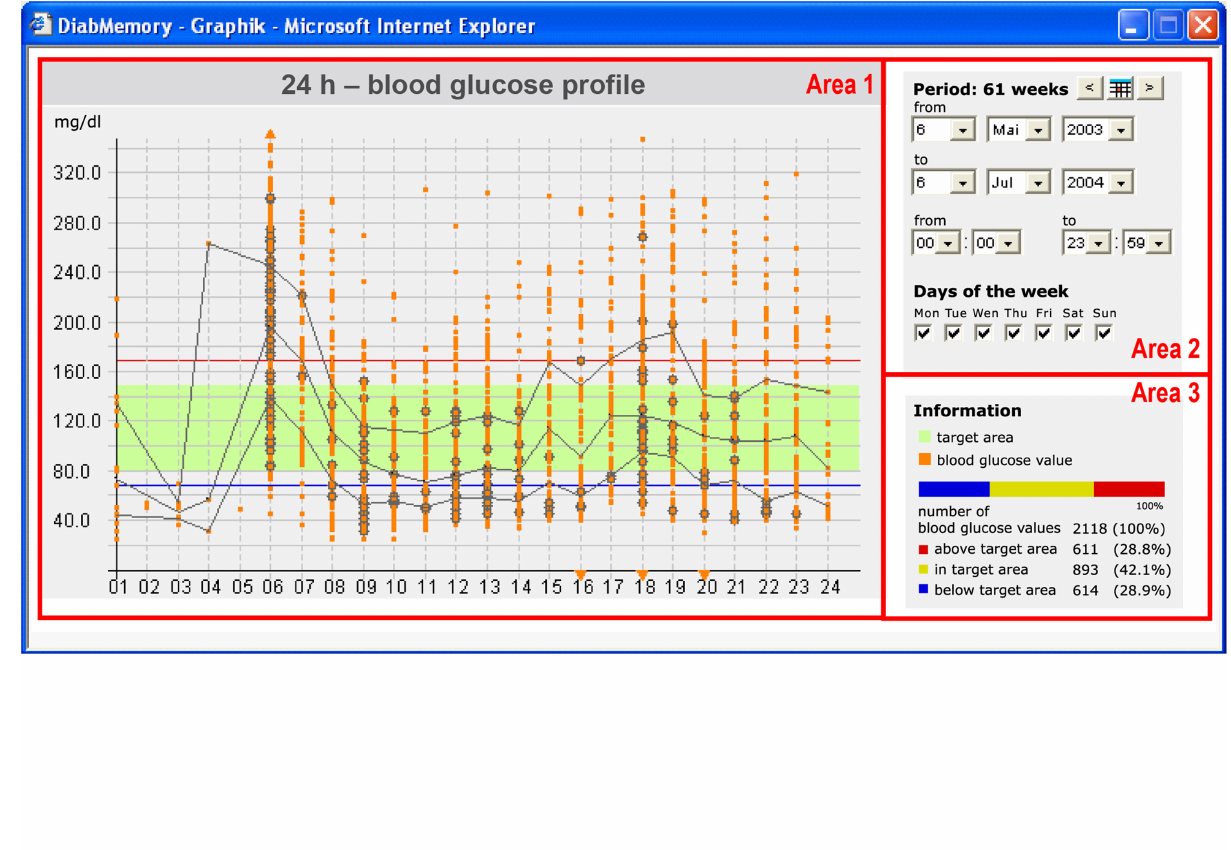
Figure 4. Graphical representation of patient blood glucose